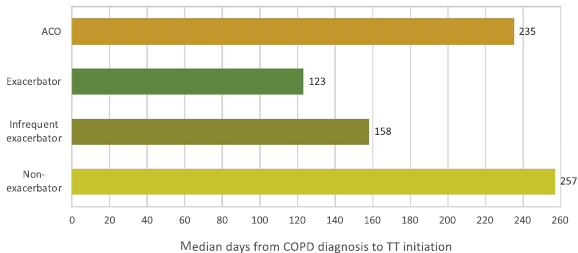
M Fig. 3 Median time from COPD diagnosis to TT according to phenotypes for patients who initiate triple therapy at or after diagnosis of COPD. COPD : chronic obstructive pulmonary disease; TT : triple therapy; ACO : asthma-COPD overlap.